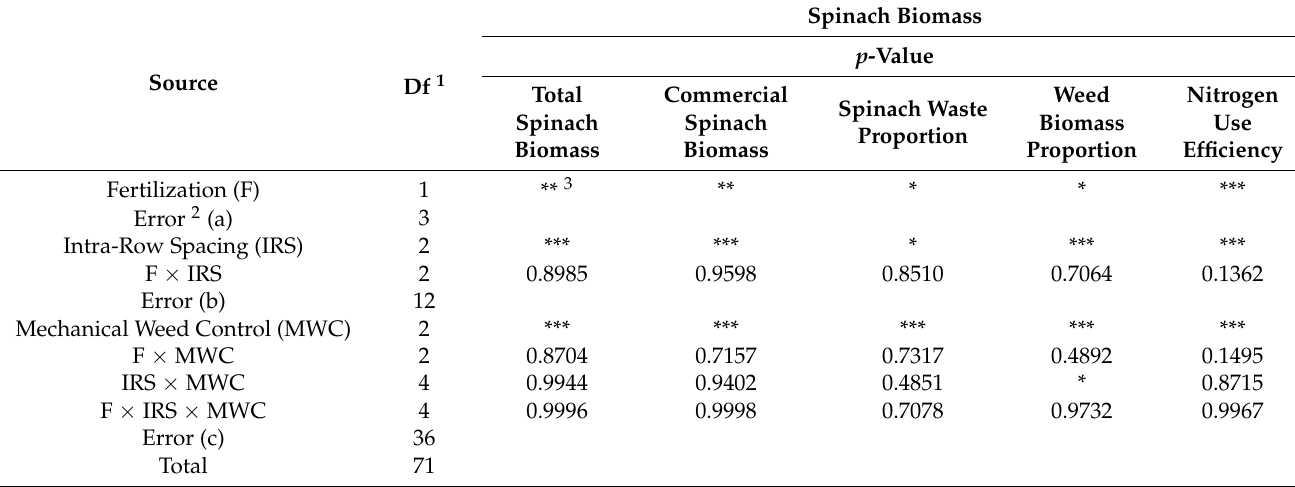
1 Df; Degrees of freedom. 2 Error (a); Block × F, Error (b); Block × IRS (F), Error (c); Block × MWC (F × IRS). 3 *, **, ***; p - Value ≤ 0.05, 0.01, and 0.001, respectively.